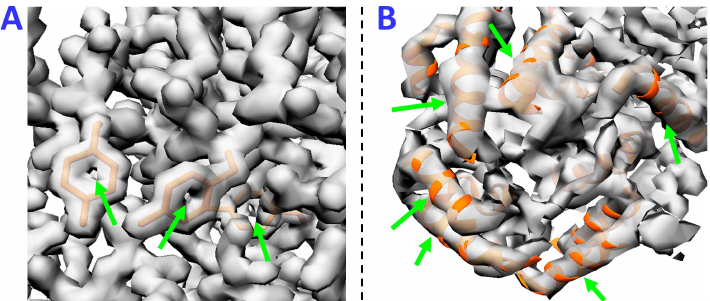
Figure 1. Approximate Resolution Assessment of cryo-electron microscopy (cryo-EM) maps. Simulated cryo-electron density maps of two example proteins at 2 Å and 6 Å, ( A , B ) respectively, illustrate how resolution can be estimated by the appearance of common structural elements. ( A ) density is thinned out in the center of aromatic rings, a feature typically observed in structures determined by X-ray crystallography at resolutions of 2 Å; ( B ) in density maps at medium (5–10 Å) resolutions, α -helices appear cylindrical in